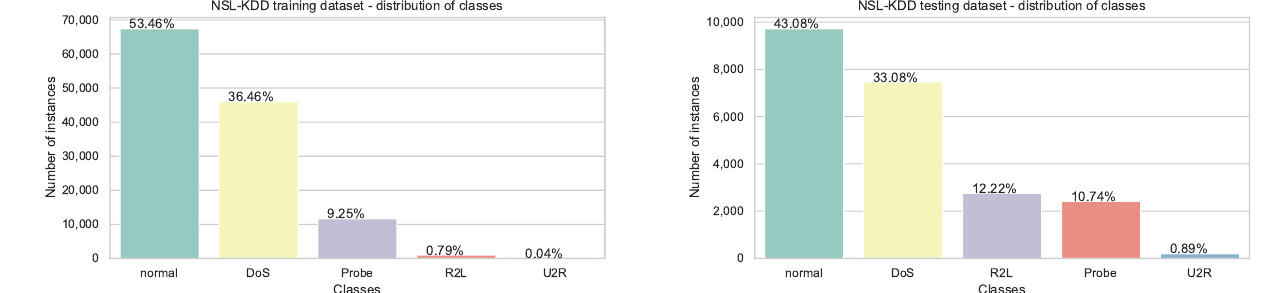
Figure 6. Distribution of classes in NSL-KDD dataset with predetermined training and testing subsets. Following the setup from the previous experiments, all hybrids are tested with N = 20 and T = 20 in 50 independent runs and best, mean, worst accuracy along with standard deviation for all four datasets with 30, 60, and 90 ELM neurons are captured and reported in Table 10. Detailed performance indicators for the best run in terms of macro averaged precision, recall, and f1-score are shown in Table 11. In both tables, the best achieved results are denoted with bold style. Convergence speed graphs for all additional simulations are shown in Figure 7. Table 10. Accuracy comparative analysis—ELM-MS-AFS vs.